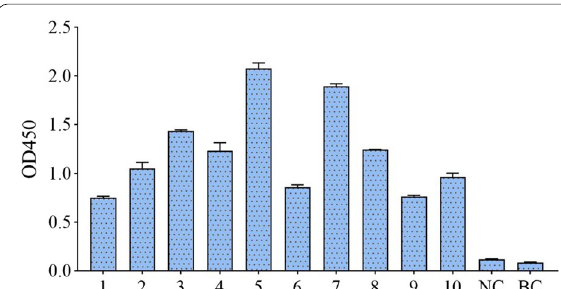
Fig. 4 Reactivity of IgY-scFv to S1 protein analyzed by phage ELISA. 1–10, scFv antibodies from randomly selected clones from the fourth bio-panning. Negative control sample (NC), PBS. Blank control sample (BC),